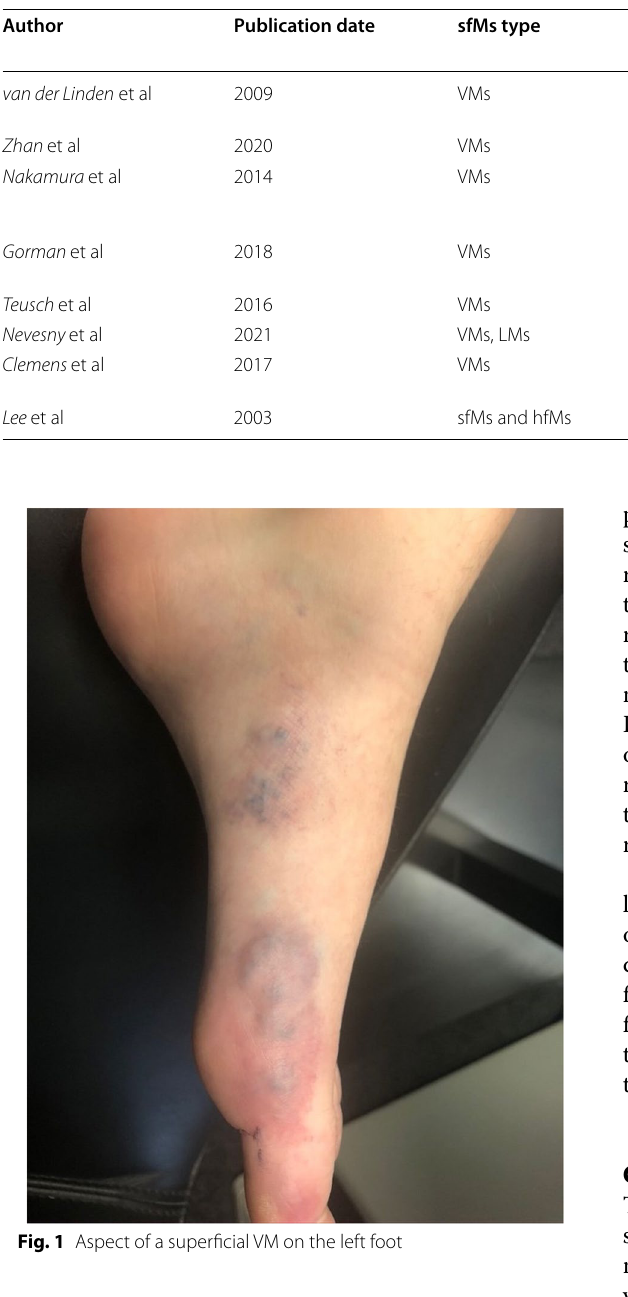
Table 14 Important studies concerning the treatment of sfM